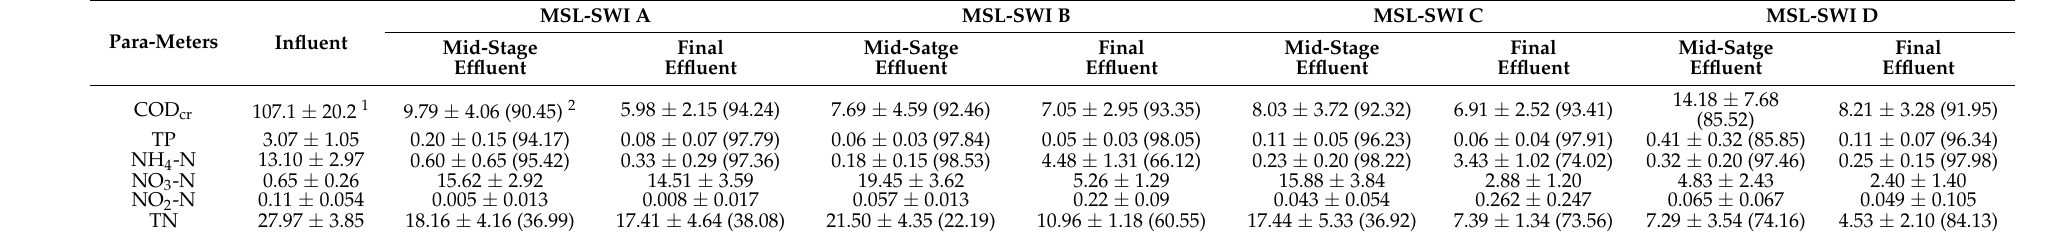
Table 2. Performance of MSL-SWI systems under various operating